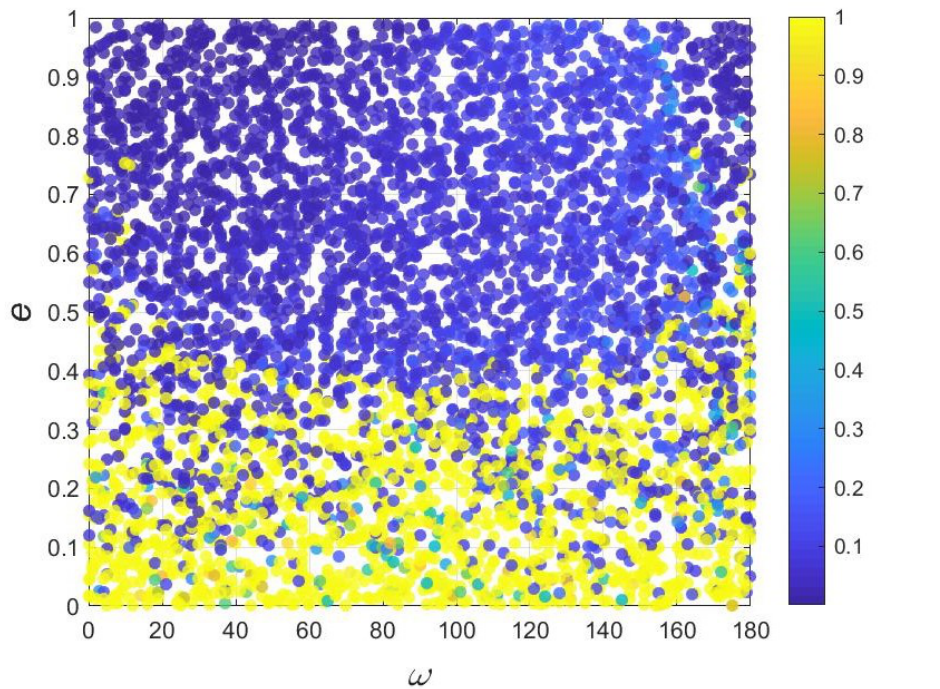
Figure 1. The lifetime of 5000 particles in 2/1 polar resonance on e − ω plane. The color bar represents the ratio of the lifetime of the particle and whole integration time span.